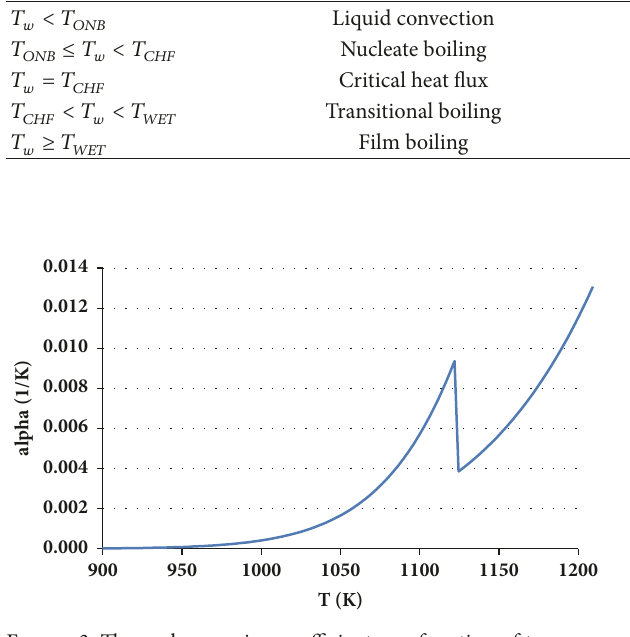
Figure 3: Thermal expansion coefficient as a function of tempera-